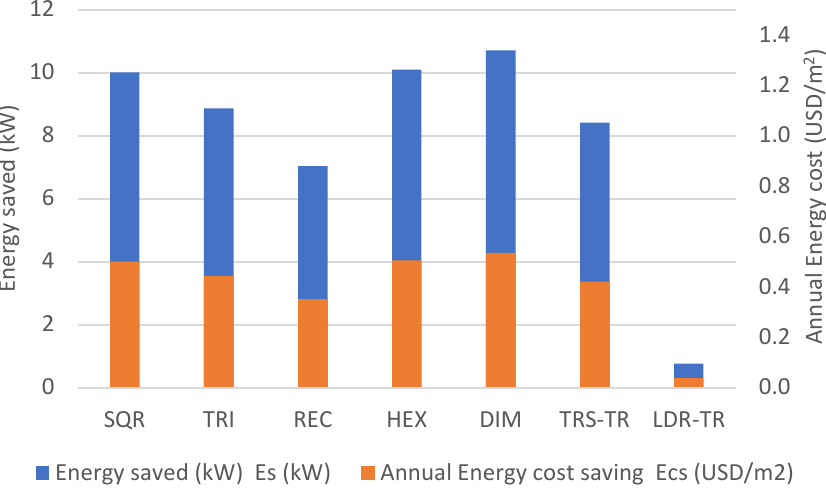
Figure 10. Energy saved and associated electricity cost reduction ($0.05/kWh) using different 3DPC infill structures versus an insulated red brick wall.